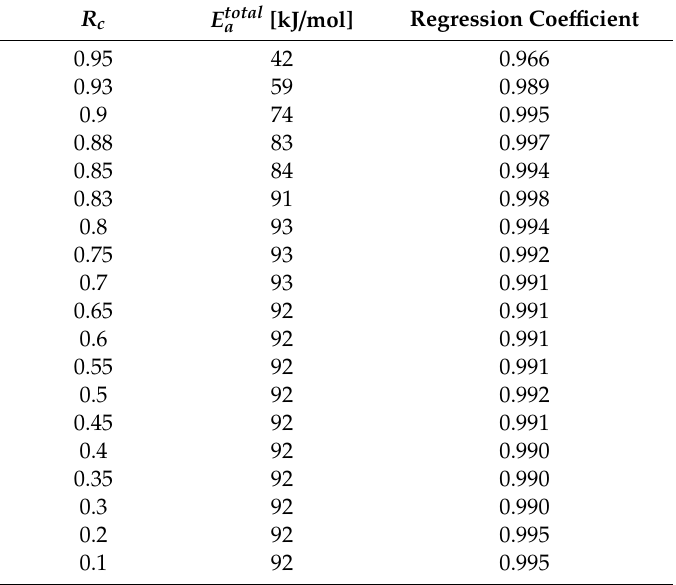
at di ff erent R c with Arrhenius